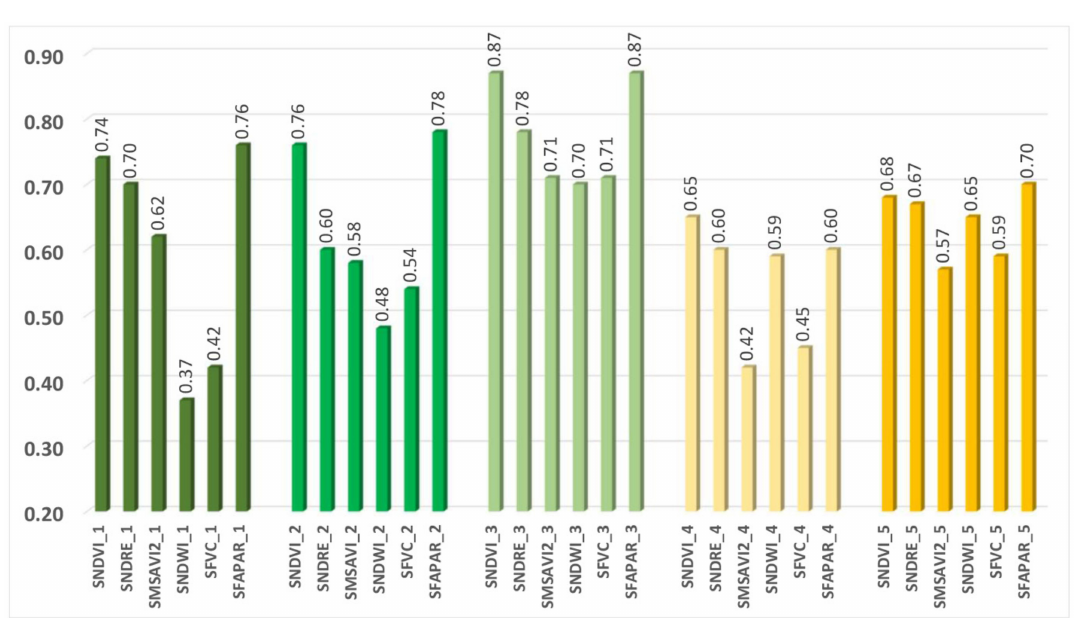
Figure 10. The Coefficients of determination representing the correlation of the S2-derived VIs and VBVs values with the